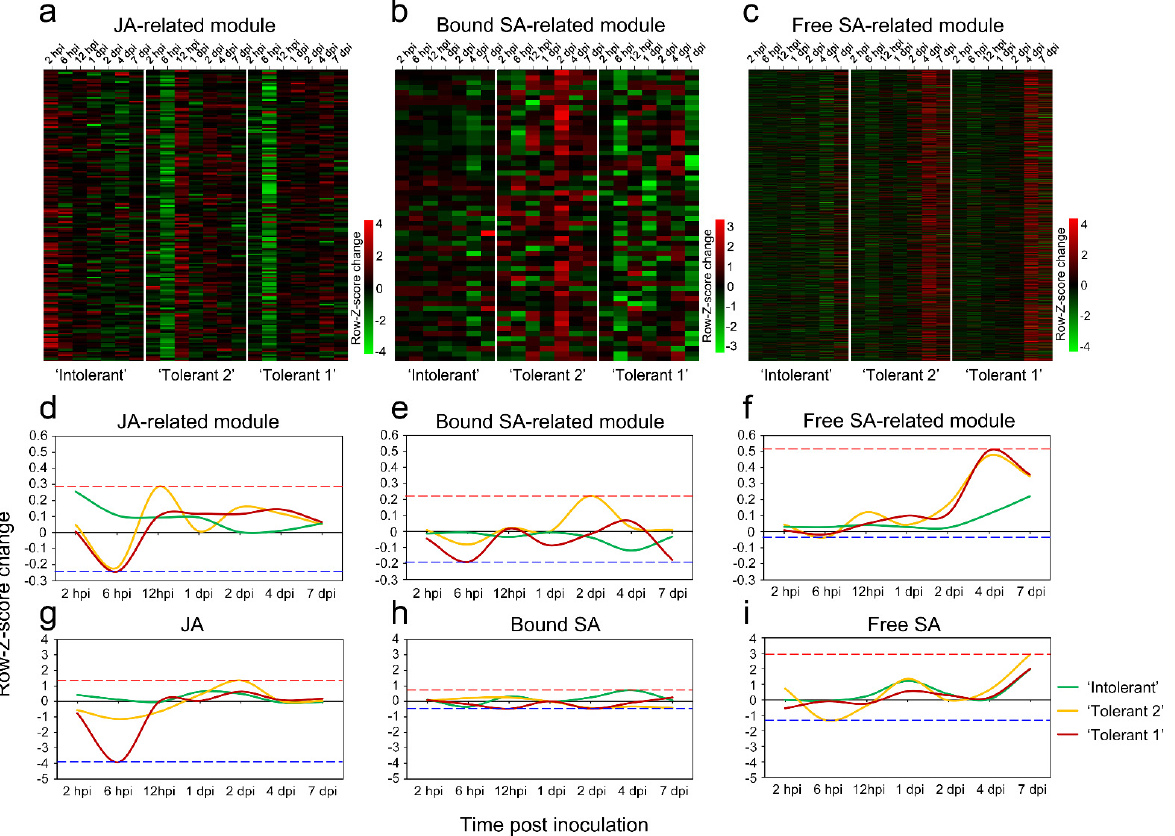
Figure 3. Gene expression patterns of JA- and SA-related modules. ( a ) Heatmap of JA-related module gene expression (rows, the Z-score was calculated for each gene, and the results are presented in rust-inoculated samples minus rust-free samples for each time point; the same for b and c) across the samples (columns; same for b and c). ( b ) Heatmap of bound SA-related module gene expression across the samples. ( c ) Heatmap of free SA-related module gene expression across the samples. ( d ) Comparison of eigengene expression ( y -axis, the Z-score was calculated for the expression of each eigengene, and the results are presented in rust-inoculated samples minus rust-free samples for each time point; the same for e and f) in the JA-related module across the samples ( x -axis, same for e and f). ( e ) Comparison of eigengene expression in the bound SA-related module across the samples. ( f ) Comparison of eigengene expression in the free SA-related module across the samples. ( g ) Comparison of the JA content ( y -axis, the Z-score was calculated for level of each phytohormone, and the results are presented in rust-inoculated samples minus rust-free samples for each time point; the same for h and i) across the samples ( x -axis; same for h and i). ( h ) Comparison of bound SA content across the samples. ( i ) Comparison of free SA content across the